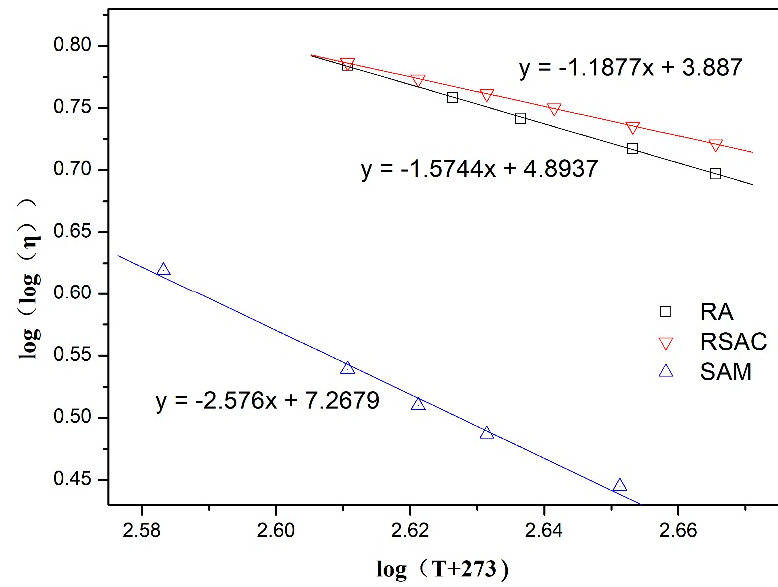
Figure 2. Double logarithmic type viscosity temperature curve of asphalt samples. Figure 2. double logarithmic type viscosity temperature curve of asphalt samples.